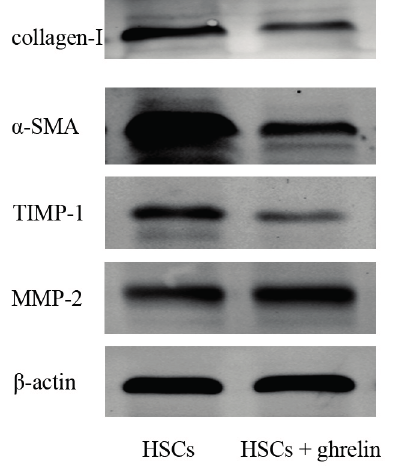
Figure 3. Ghrelin inhibited activation of HSCs and expression of MMP2 and TIMP1 in BDL-induced liver fibrosis. ( A ) Western blot and real-time PCR analyses of collagen I, α -SMA, TIMP1, and MMP2 in the CCl 4 group; and ( B ) Immunohistochemical staining (200×) of collagen I and α -SMA protein in BDL-induced fibrotic liver tissues. The positive rate was analyzed with Image-Pro Plus 6.0. Data are expressed as the mean ± SD ( n = 7, * p < 0.05 for the BDL vs. sham group, # p < 0.05 for the ghrelin + BDL vs. BDL group). The scale bar of each figure is 200 μ m, and the magnification is 200×.